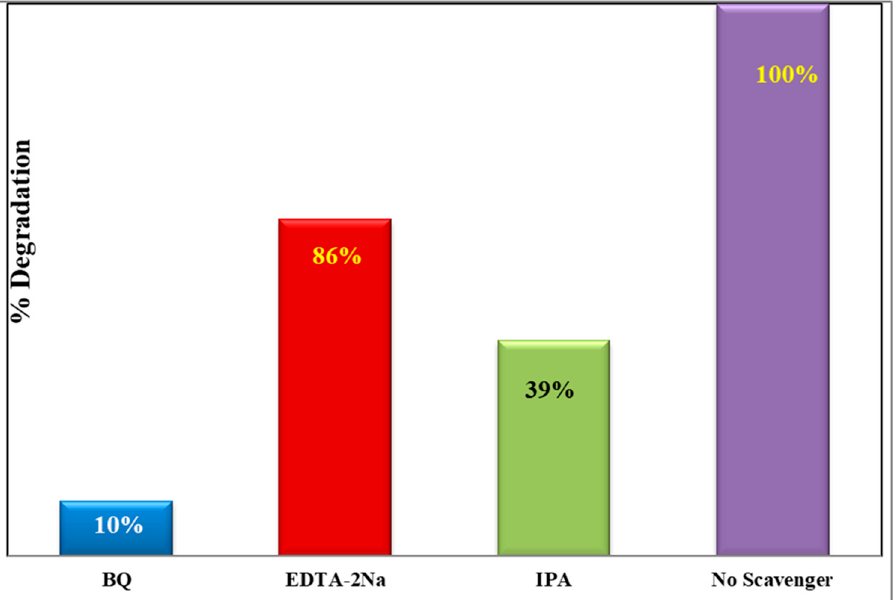
Figure 7. Role of radical scavengers in the photocatalytic degradation of MB with Mn-ZnFe 2 O 4 /50% S-g-C 3 N 4 .